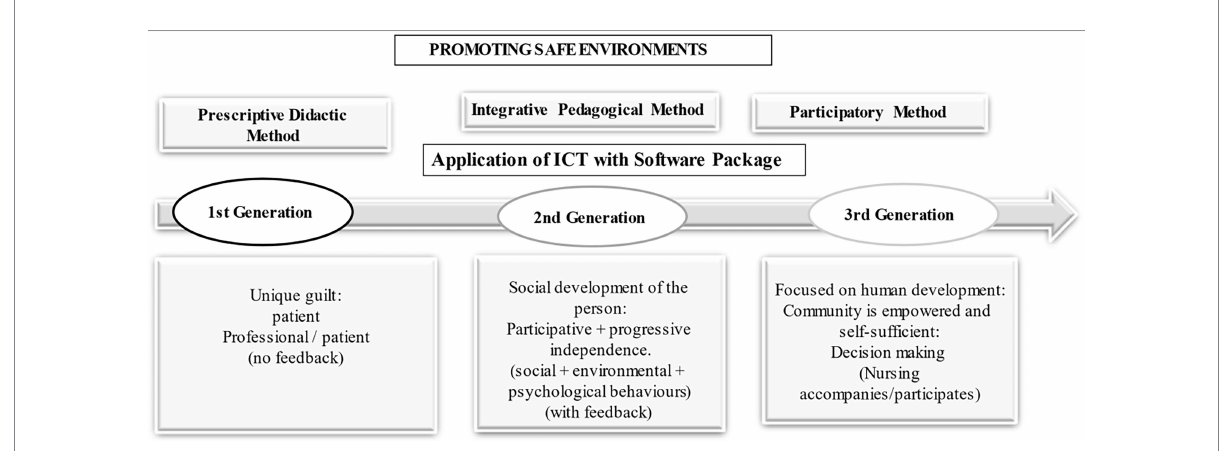
FIGURE 4 Health education method: application of ICT with software package to improve the training of future professionals and health and social care (Author’s own